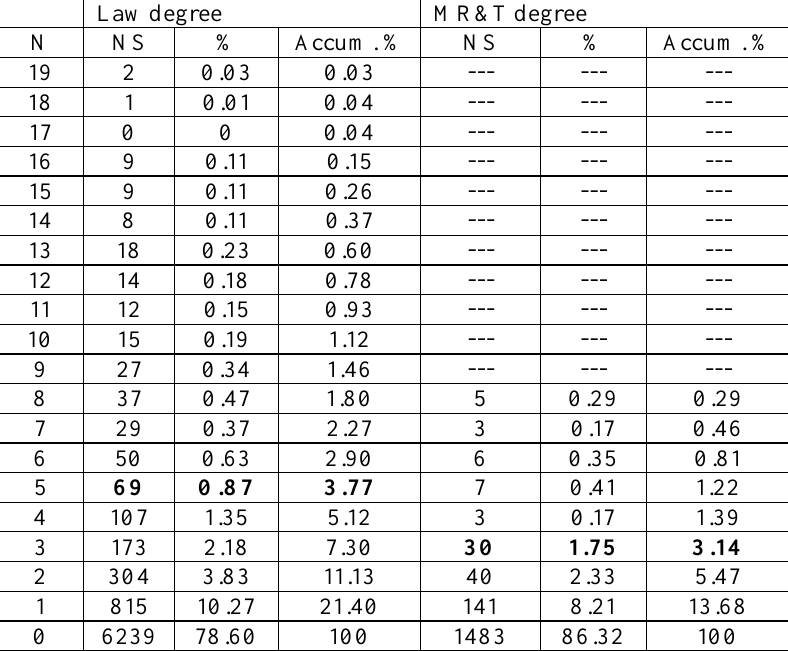
Table 2 Analysis of the Break Sequences from Law (left) and Market Research & Techniques Studies